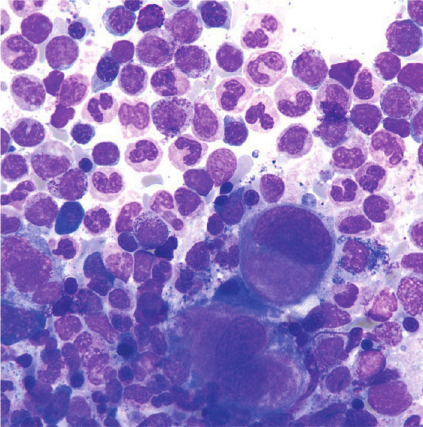
Figure 7: Mildly hypercellular bone marrow for age (50–60% cel- lularity) (hematoxylin-eosin, original magnification × 100).